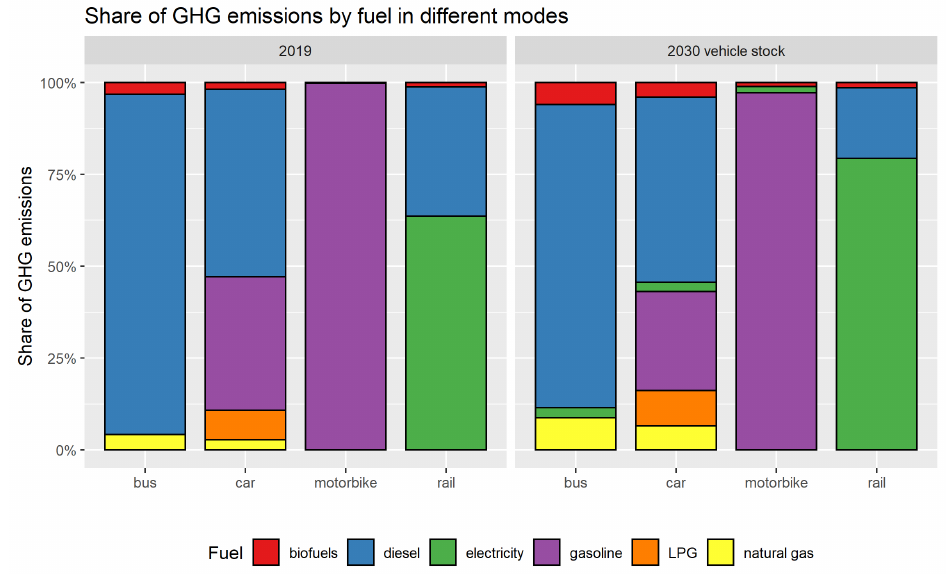
Figure 5. GHG emissions of daily trips by mode in Lombardy, considering a WTW perspective. Share of emissions by fuel in different